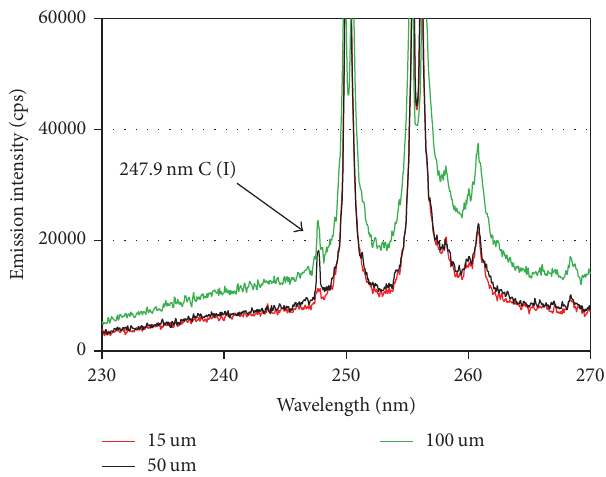
Figure 1: LIBS spectra obtained from the different laser irradiated diameters of 15, 50, and 100 𝜇 m with respect to the surface of Zn metal. The chamber gas was Ar and the laser output energy to the surface of Zn was fixed at 3.5